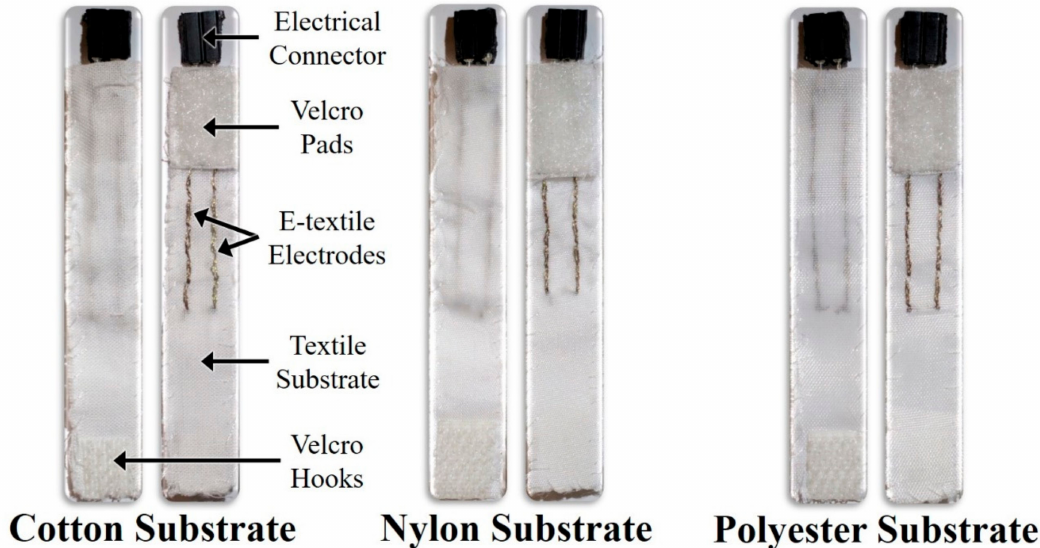
Figure 5. Images of e-textile EDA electrode strap prototypes using cotton, nylon, and polyester textile